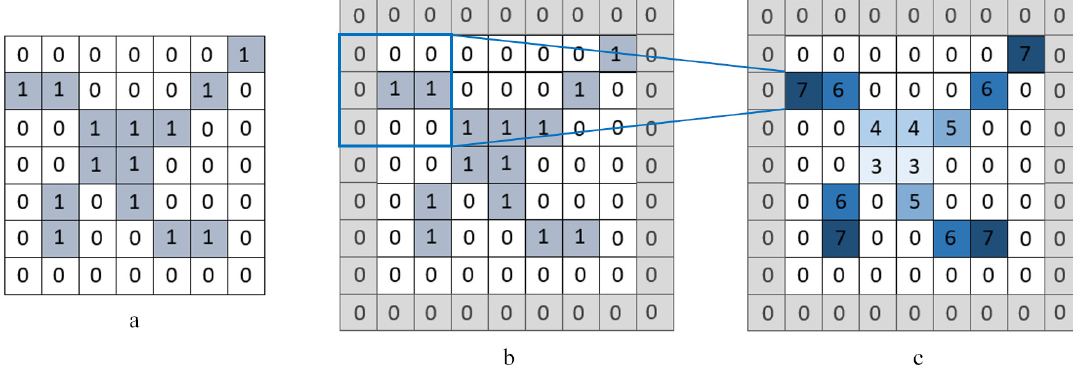
Figure 9. Endpoint detection of tassels. ( a ) 0, 1 matrix of tassel skeleton. ( b ) Matrix after applied padding, the blue box is a 3 × 3 window. ( c ) Pixel with the deepest color are the endpoints of